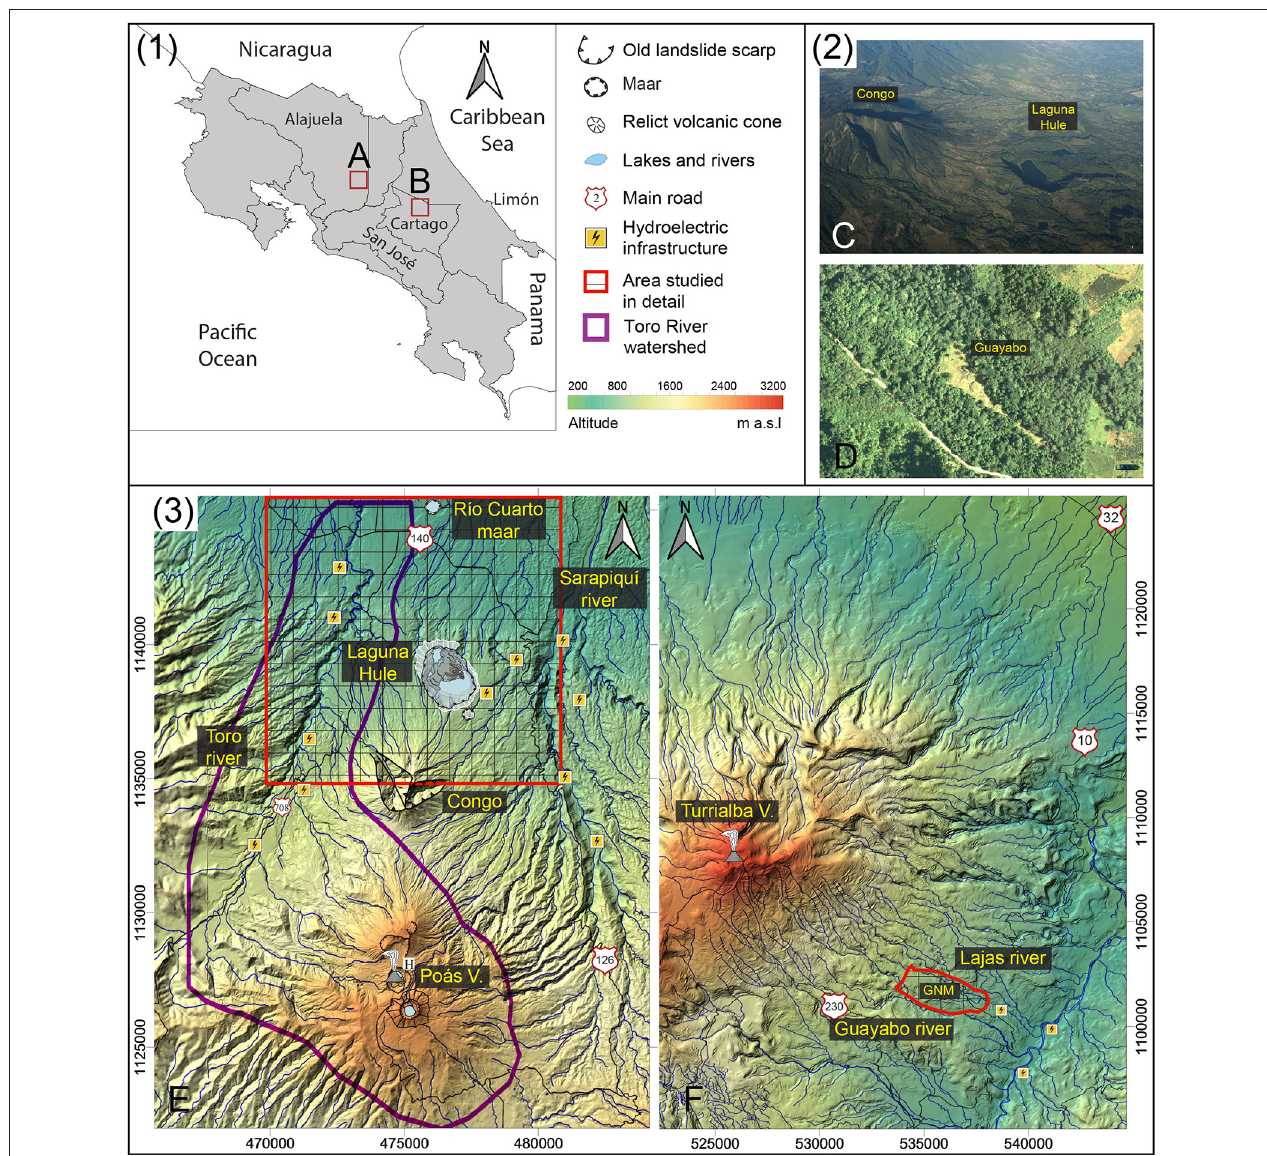
FIGURE 2 | Location of the studied areas: (1) Map of Costa Rica where the location of Poás (A) and Turrialba (B) Volcanoes are highlighted; (2C) aerial photos from northern Poás (2D) and the Guayabo National Monument; (3) DEMs of Poás Volcano based on LiDAR (E) , and Turrialba Volcano based on local topographic maps (F) . Areas in red are detailed in Figures 3 and 5, respectively. Local coordinates are in CRTM05.